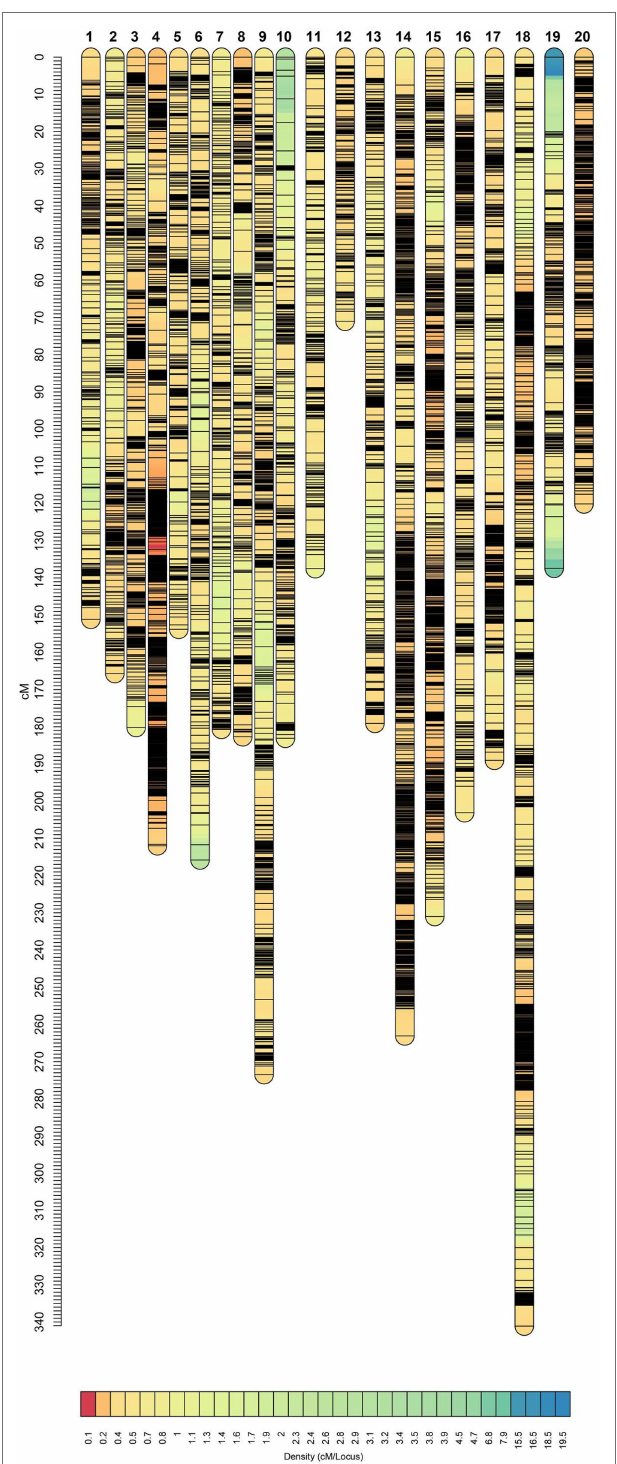
FIGURE 7 | Genetic linkage map constructed from